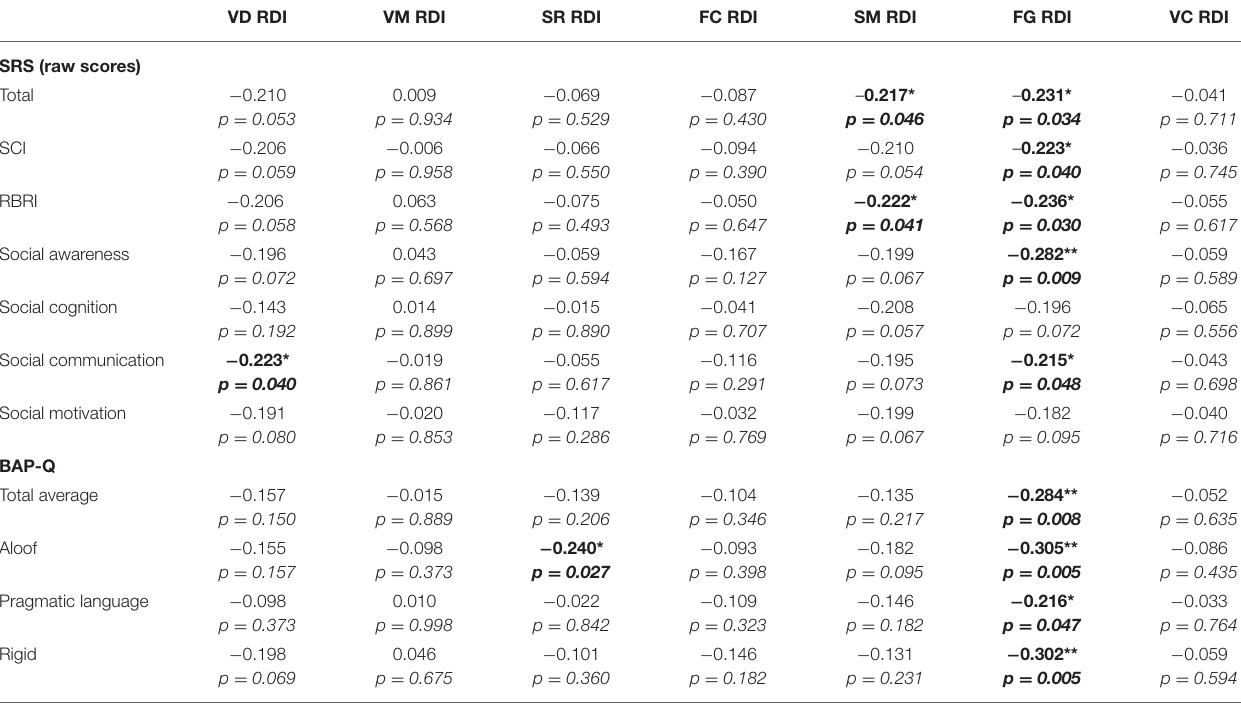
TABLE 6 | Partial correlation (FSIQ) between BAP-Q and TVPS RDI scores with correction for multiple